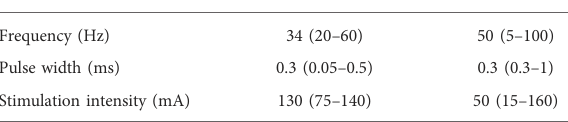
TABLE 1 Median (range) of frequencies, pulse widths and stimulation intensities used by all studies which use FES and TENS or TSCS. Where studies report a range of frequencies or pulse widths being used, the average has been taken. Where studies reported a range of stimulation intensities, the maximum intensity was used to account for interventions which included sham stimulation or passive movement (i.e. used 0 mA). In the case of stimulation intensity, only 16 studies reported a quantitative value (see Supplementary Table S2). These values exclude those studied by Vodovnik et al. (1987) due to the large variation in frequencies and pulse widths